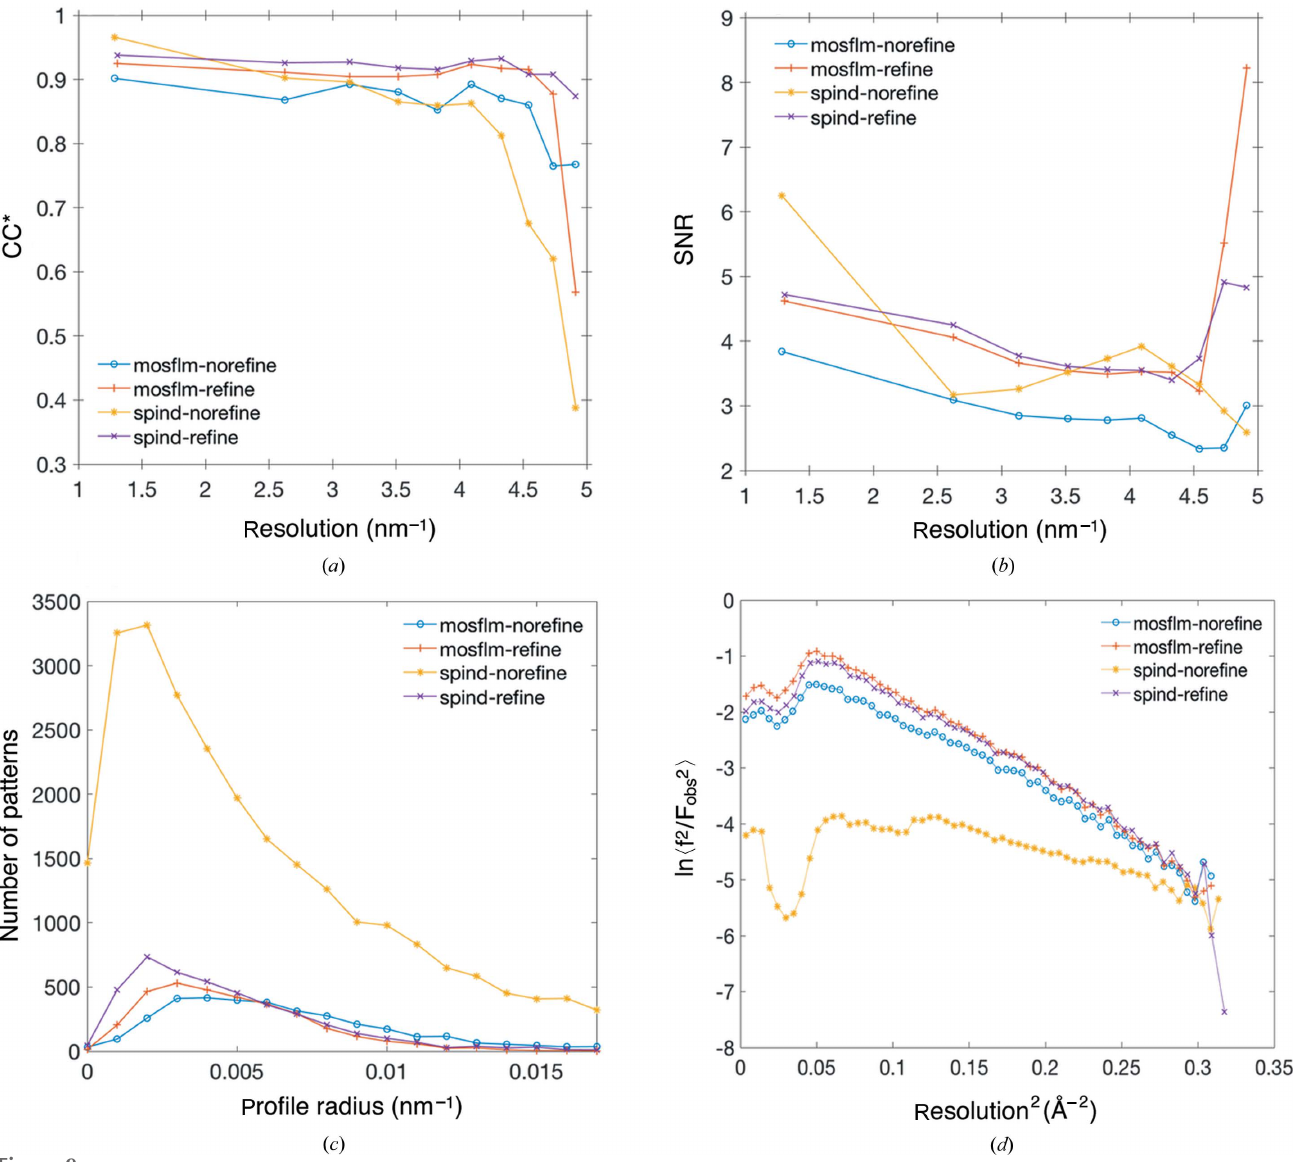
Figure 9 Figures-of-merit for the ClR data set indexed with various indexing algorithms. ( a ) CC*, ( b ) SNR, ( c ) reflection profile radii and ( d ) Wilson plots. The keywords ‘refine’ and ‘norefine’ represent the on and off status of the lattice-refinement option in indexamajig of CrystFEL in the indexing process. SPIND -refine has better figures of merit for this data set than the other methods. Small modal reflection profile radii indicate that orientation determined by SPIND is often more accurate than MOSFLM with and without orientation